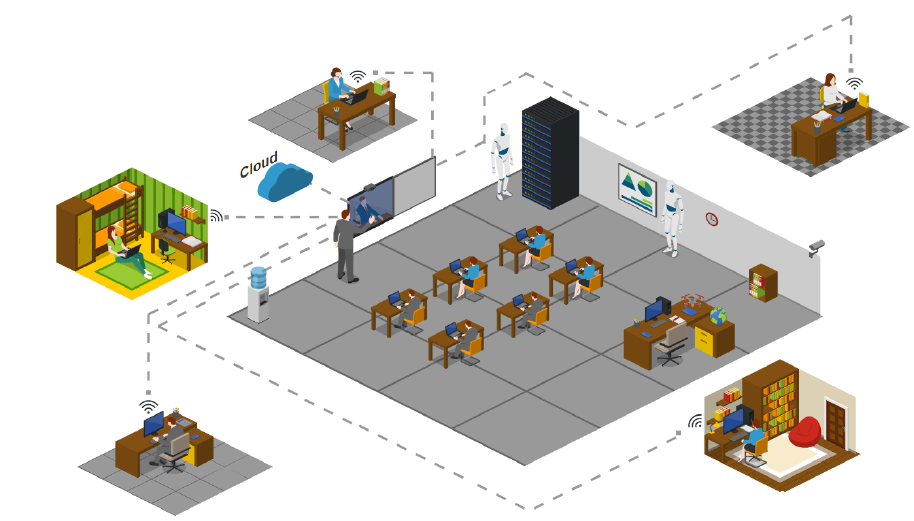
Figure 10. Hybrid Educational IoT